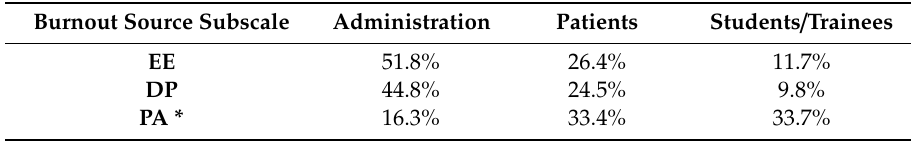
Table 5. Burnout prevalence among the three major sources of human interactions. Percentages indicate the levels of burnout, as defined by Maslach and Jackson